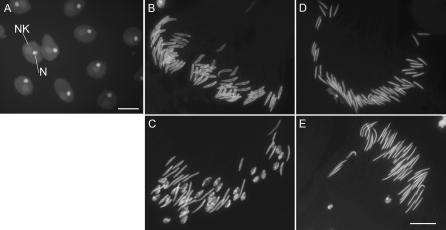
Abnormal Transformation of the Y-Bearing Sperm Detected by DAPI Staining(A) Onion stage (SSR12-2-7 nmy, 16 °C) similar to that in Figure 4A and 4B. Abnormal nucleoplasmic vacuoles are not visible under the fluorescence microscope. Nucleus (N) and nebenkern (NK) are indicated. Scale bar: 20 μm.(B and C) Spermatids of SSR12-2-7 nmy have strong dimorphism in nuclear transformation at 16 °C (C) as compared with simB Nmy (B).(D and E) The nuclear dimorphism of SSR12-2-7 nmy disappears at 26 °C (E) as compared to simB Nmy (D). Scale bar for B-E: 10 μm.